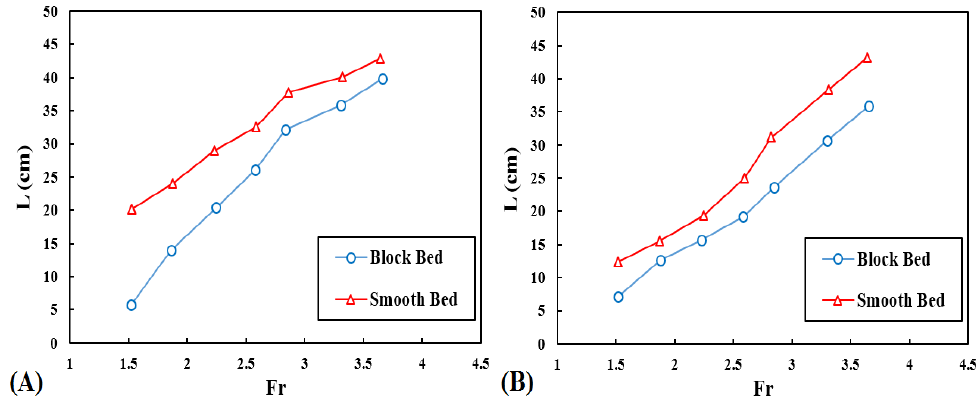
Figure 12. Di ff erence in jet length in smooth and block beds. Bucket with ( A ) θ = 32 ◦ and ( B ) θ = 52 ◦ . Figure 12. Difference in jet length in smooth and block beds. Bucket with ( A ) θ = 32° and ( B ) θ = 52°.